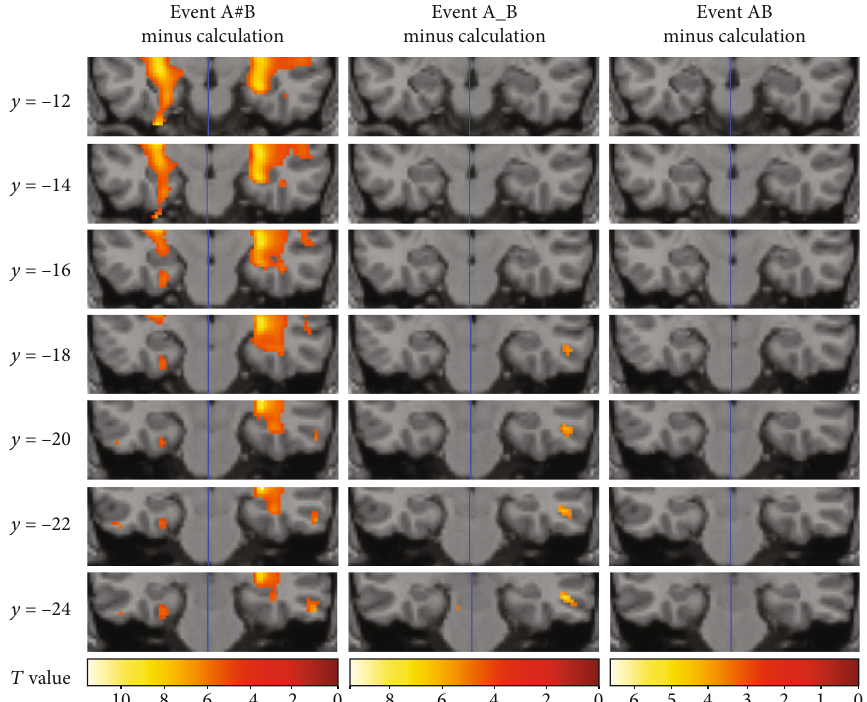
Figure 3: Territories of MTL activities shown when Events A#B, A_B, and AB were, respectively, contrasted with the calculation